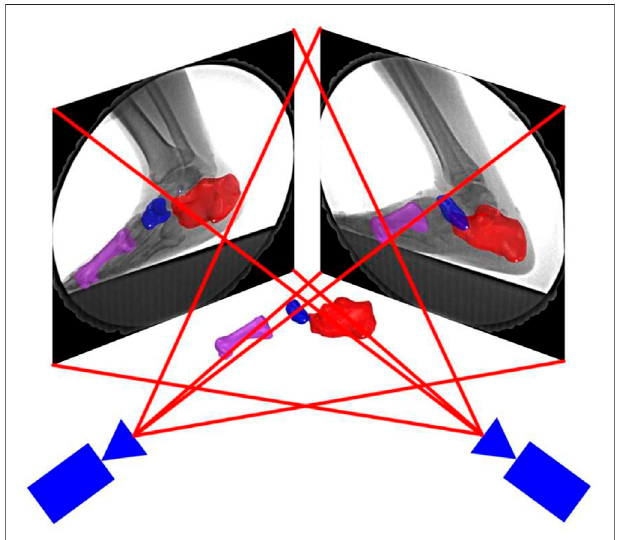
FIGURE 3 | 3D – 2D registration. Bone positions were adjusted by translation and rotating the bone models in the software until the edge of the bones matched with the radiographic images.